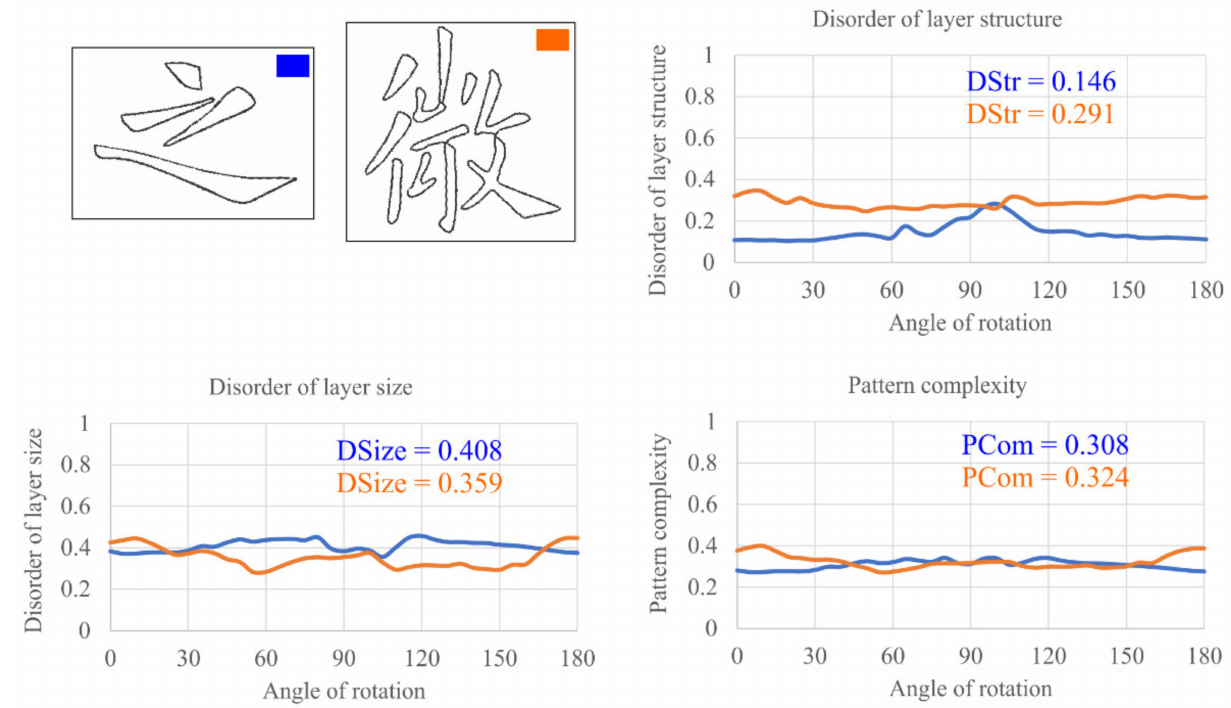
Figure 7. Comparison of morphological characteristics of two Chinese characters. Credit: Wikipedia